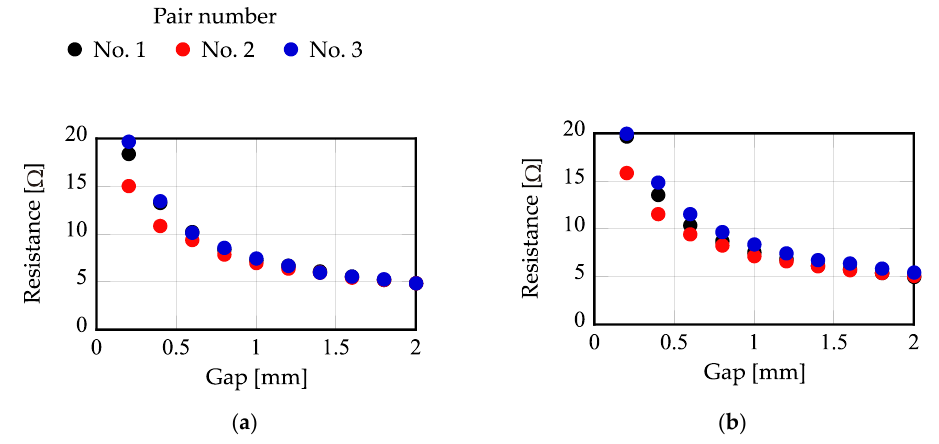
Figure 14. Measured equivalent resistance of electromagnet at various gaps. ( a ) Primary electromagnet. ( b ) Secondary electromagnet.